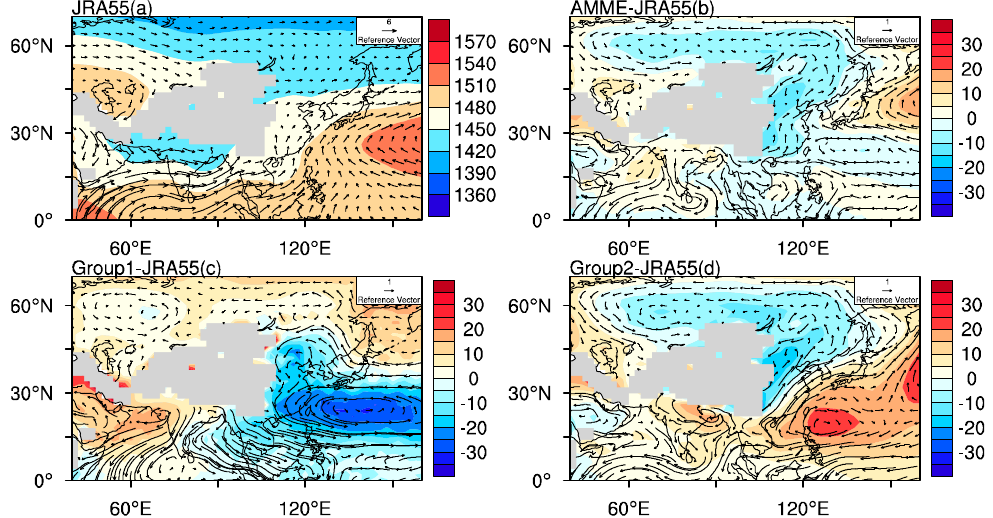
Figure 14. Summer (June-August) seasonal-mean geopotential height (shaded: gpm) and wind vectors (m/s) at 850 hPa from ( a ) JRA55 and differences between AMME ( b ), Group 1 ( c ), Group 2 ( d ), and JRA55.